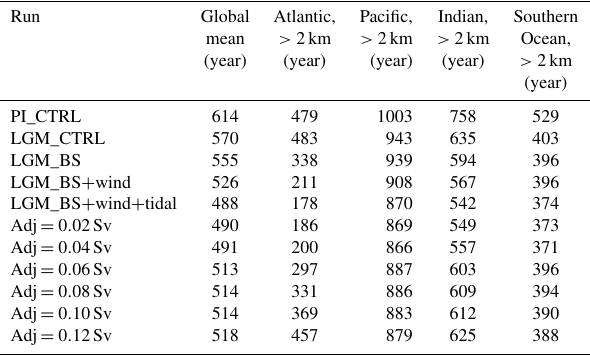
Table A1. Mean ideal water ages for the global ocean and for the different basins below 2km water depth.